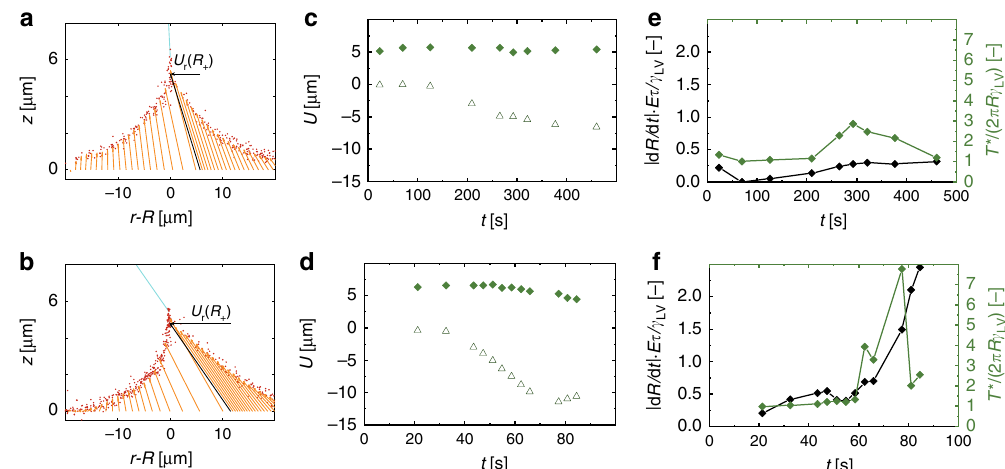
Fig. 6 Displacement and effective line tension of a drying droplet on a compliant substrate. a Wetting ridge shape and displacement vectors projected to the rz -plane at t = 460 s during slow evaporation ( rH = 90%, droplet in Fig. 3a). b Wetting ridge shape and displacement vectors projected to the rz -plane at t = 77 s during fast evaporation ( rH = 15%, droplet in Fig. 3d). The black vectors in ( a ) and ( b ) mark U ( r = R + ) and the blue lines in ( a ) and ( b ) mark the liquid – vapor interface. Plot of vertical displacement, U z ( r = R ) (diamonds), and radial displacement just outside the contact line, U r ( r = R + ) (triangles), for c slow evaporation ( rH = 90%, droplet from Fig. 3a) and d fast evaporation ( rH = 15%, droplet from Fig. 3d). Plots of | dR / dt | E τ / γ LV vs. normalized effective line tension, T * /(2 π R γ LV ), vs. t for e slow evaporation ( rH = 90%, droplet from Fig. 3a) and f fast evaporation ( rH = 15%, droplet from Fig. 3d). Source data are provided as a Source Data fi le for ( c – f